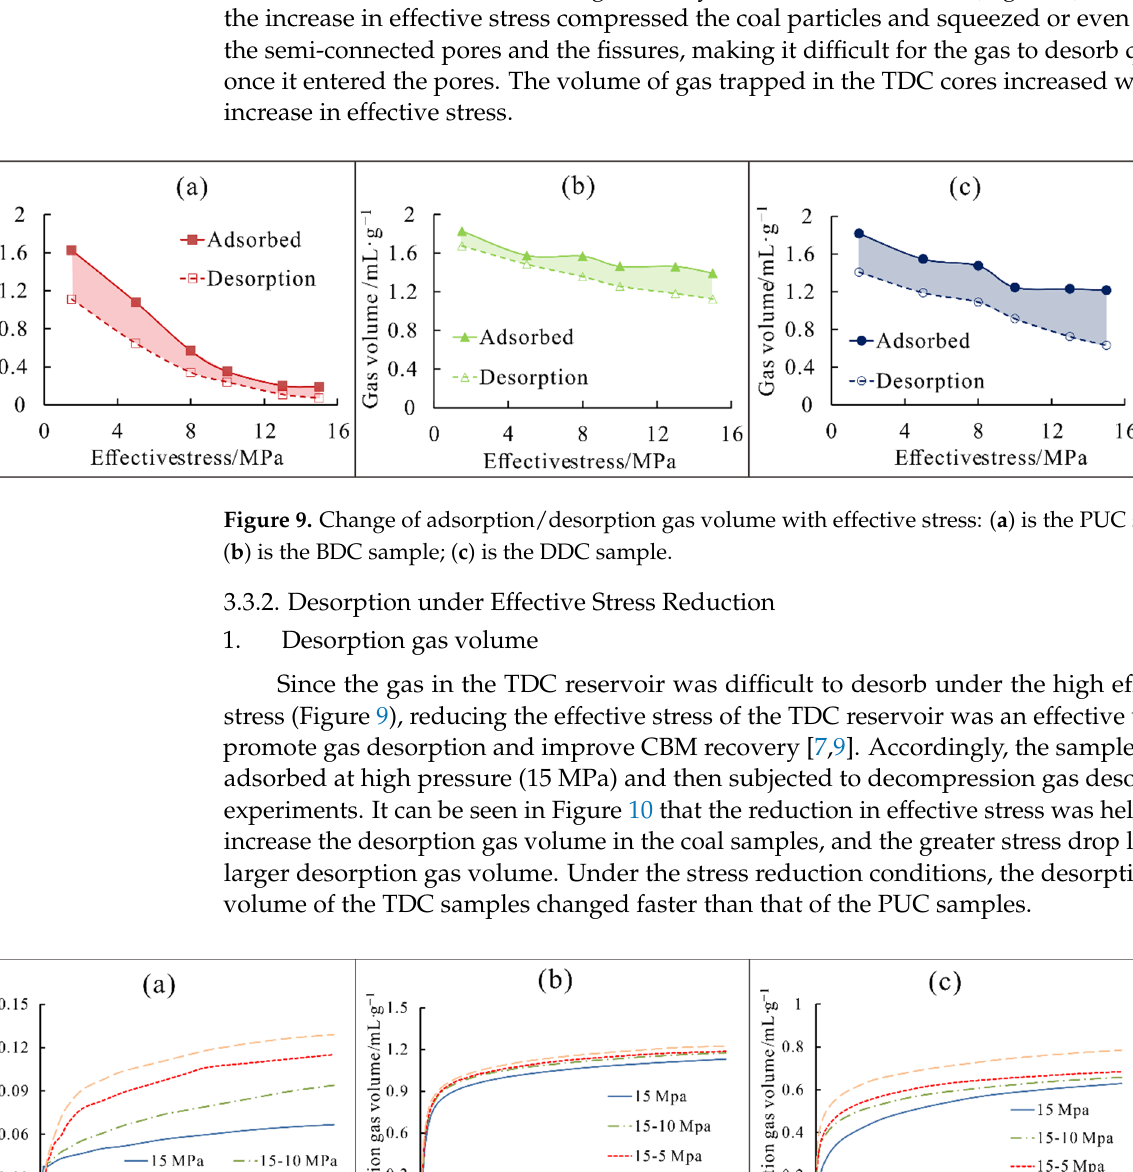
12 of 20 Figure 8. The change of desorption gas volume and desorption rate with time: ( a ) is the PUC sam- ple; ( b ) is the BDC sample; ( c ) is the DDC sample.